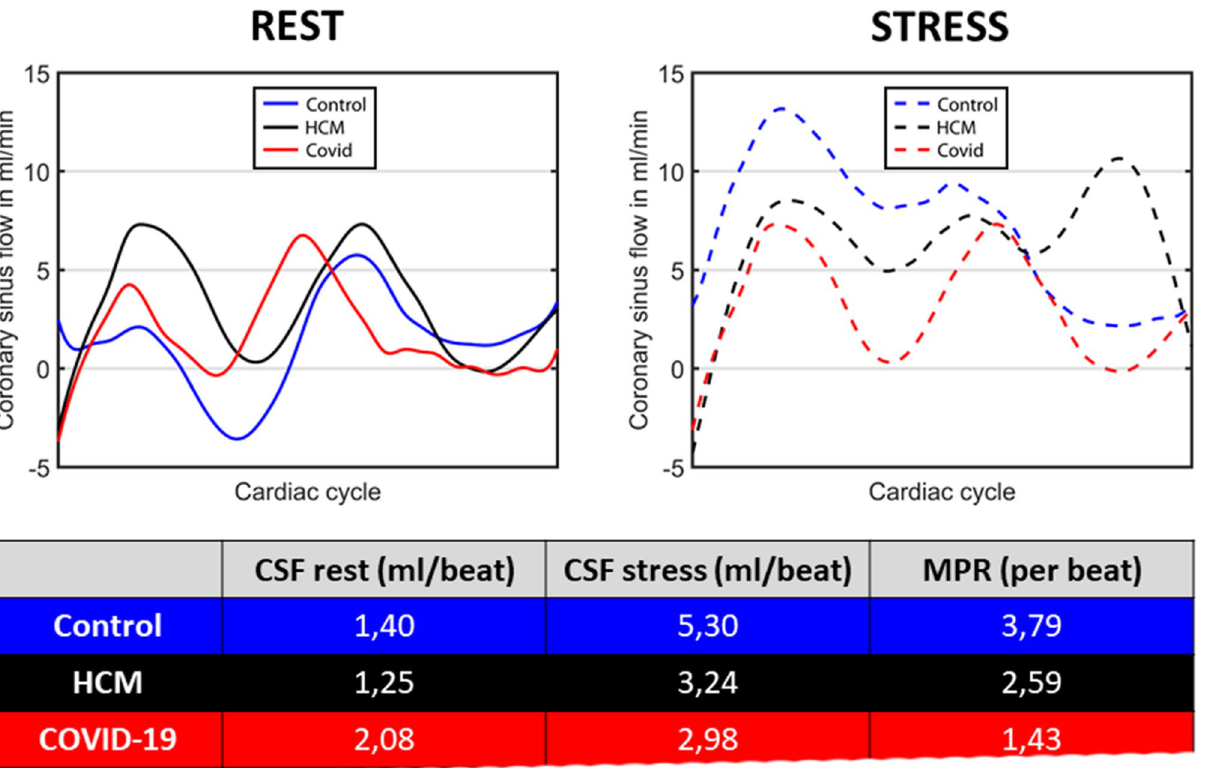
Figure 2. Flow-velocity curves of the coronary sinus (CS) of one representative patient from each study group at ( A ) rest and ( B ) during regadenoson stress (at maximal vasodilation). The results of a patient who recently recovered from coronavirus disease (COVID-19) (red curve), a patient with hypertrophic cardiomyopathy (HCM) (black curve) and of a healthy control (blue curve) are shown in